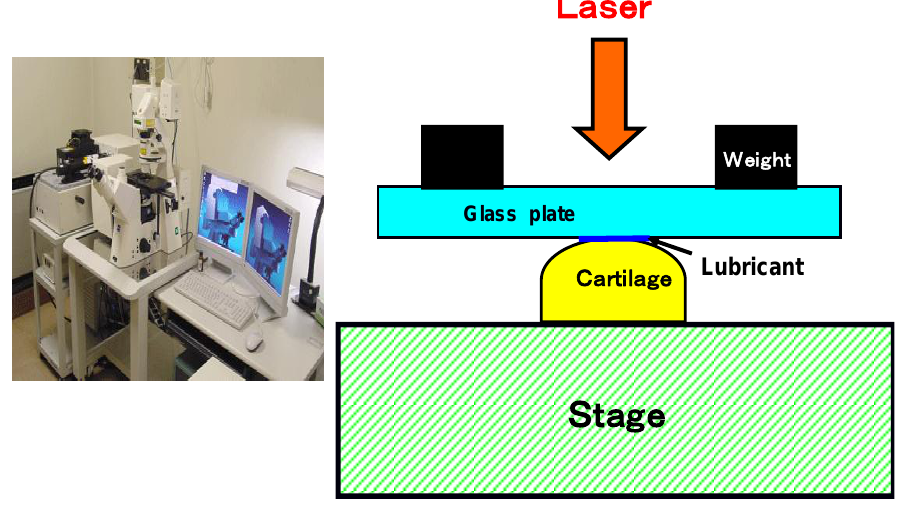
Figure 7. Photograph of real-time 1LM21 confocal laser scanning microscopy (CLSM) and schematic cross-section view of the CLSM observation.